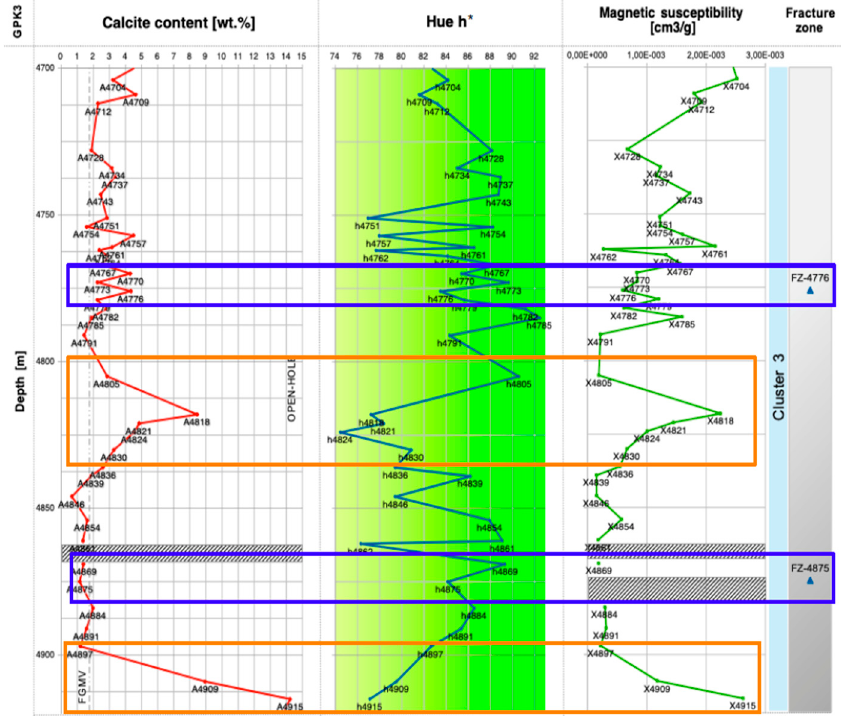
Figure 6. Calcite content, hue and magnetic susceptibility of granite samples in the third fracture cluster (cluster 3, Figure 4) encountered in the deep reservoir, in well GPK ‐ 3. Two fracture zones are present (FZ ‐ 4776 and FZ ‐ 4875), highlighted by blue rectangles. Orange rectangles highlight zones in which the correlation between the three parameters is particularly visible. Grey dashed zones indicate that no samples are available.